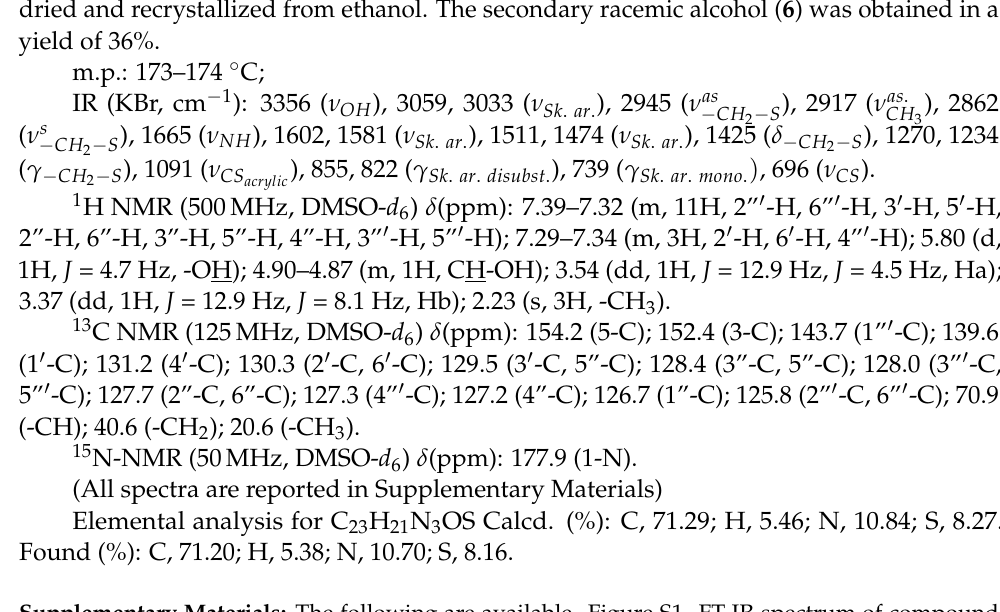
CDCl 3 ; Figure S12. FT-IR spectrum of compound 6 ; Figure S13. 1 H NMR spectrum of compound 6 in DMSO- d 6 ; Figure S14. 13 C-NMR spectrum of compound 6 in DMSO- d 6 ; Figure S15. COSY 1 H- 1 H spectrum of compound 6 in DMSO- d 13 C DEPT135 spectrum of compound 6 in 6 ; Figure S16. DMSO- d 6 ; Figure S17. HMBC 1 H- 13 C spectrum of compound 6 in DMSO- d 6 ; Figure S18. HMBC 1 H- 15 N spectrum of compound 6 in DMSO- d 1 H- 13 C spectrum of compound 6 ; Figure S19. HSQCCED 6 in DMSO- d 6